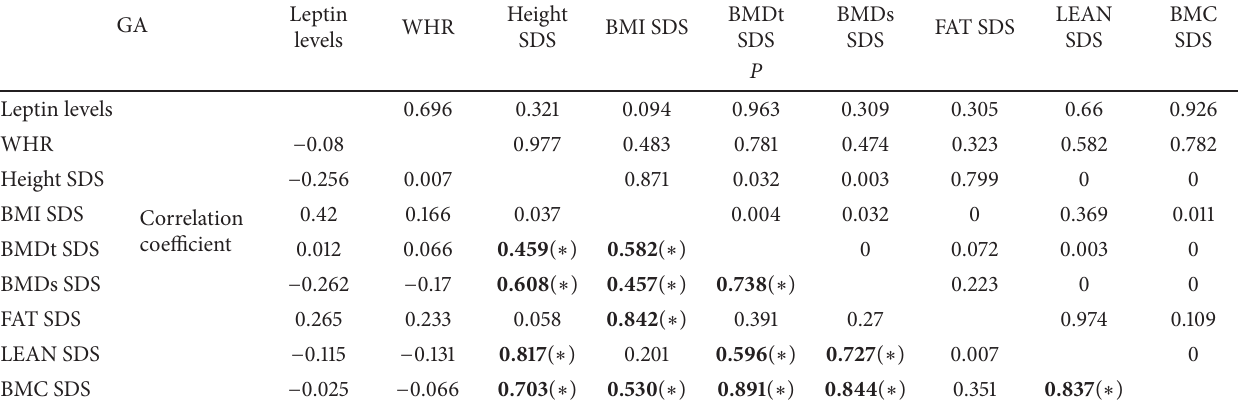
Table 6: Correlation between anthropometric and densitometric parameters in the group with LEPR gene genotype